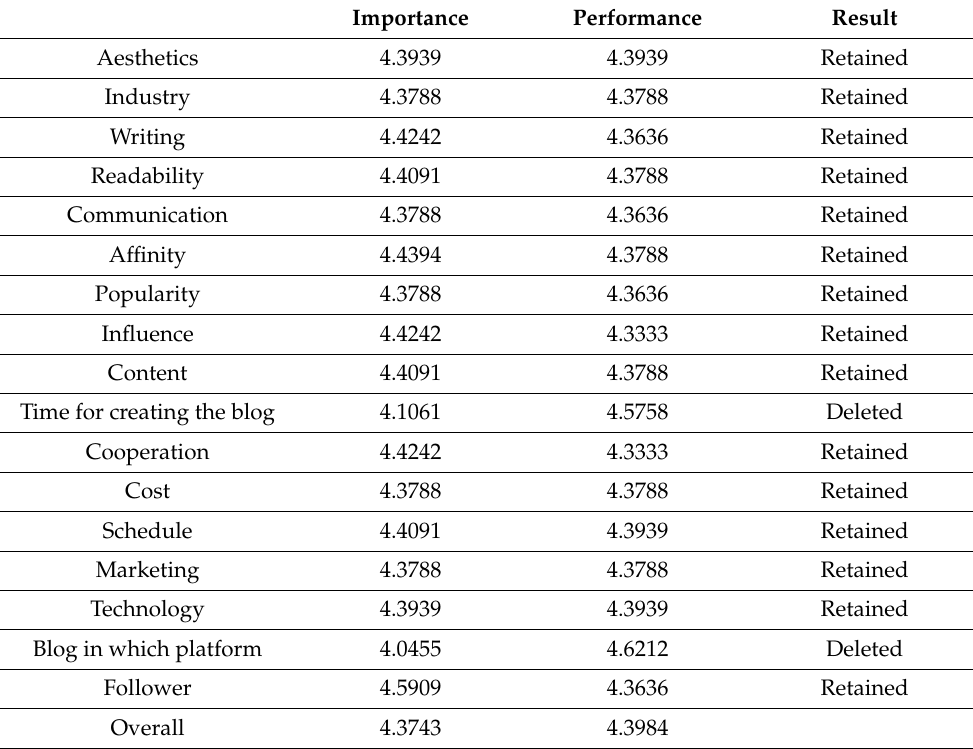
Table 1. Importance and performance mean scores of the criteria.